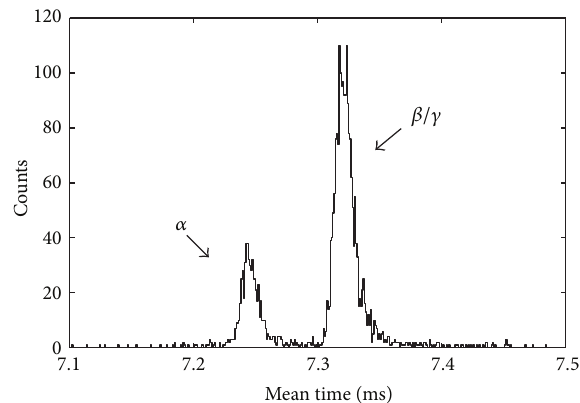
Figure 4: Distribution of mean-time parameter in 4MeV < 𝐸 < 5 MeV region of alpha-equivalent energy. Discrimination power was found to be 7.6 from fitting each group of distribution with a normal Gaussian function. Right-hand side tail is noticeable for the two groups toward higher mean-time value.